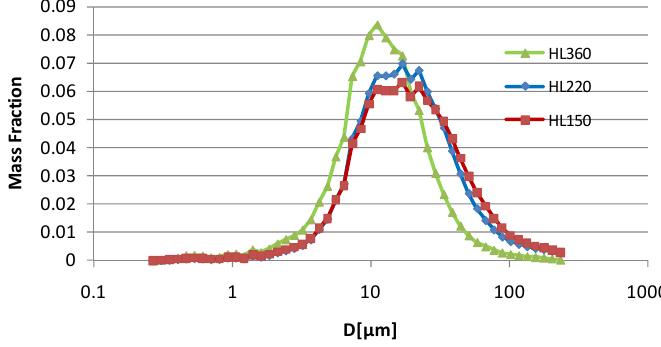
Figure 4. Measured integral droplet size distributions for three shaping air flow rates: 150, 220, 360 L/min.